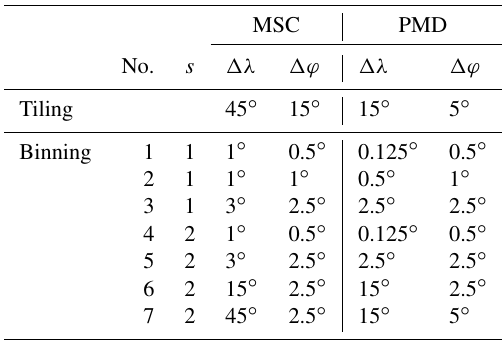
Table 6. Spacing of meridians ( (cid:49)λ ) and parallels ( (cid:49)ϕ ) for the def- initions of tiling and binnings for MSC and PMD evaluations, re- spectively. Binning resolutions depend on surface type: land ( s = 1) and ocean ( s =